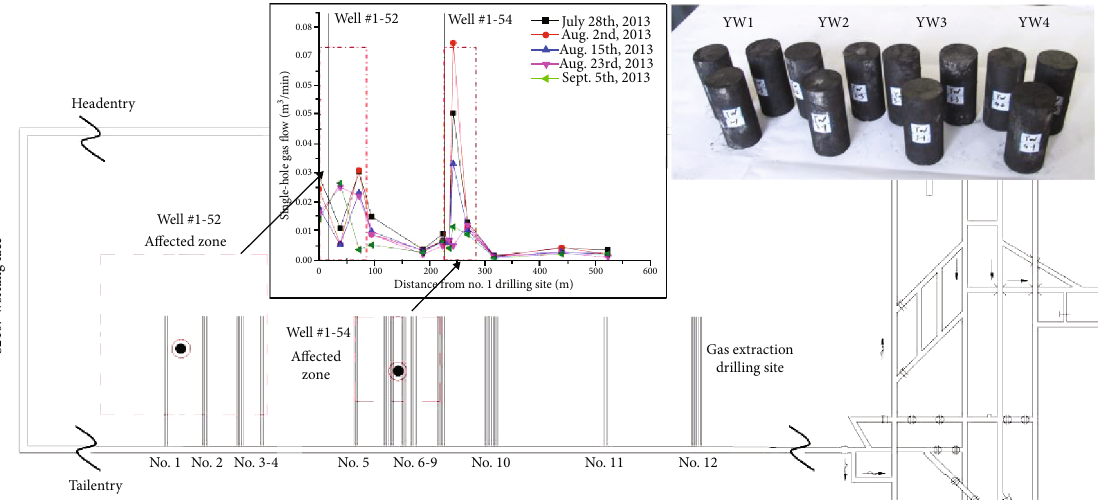
Figure 1: A ff ected zone of surface wells where samples were taken.